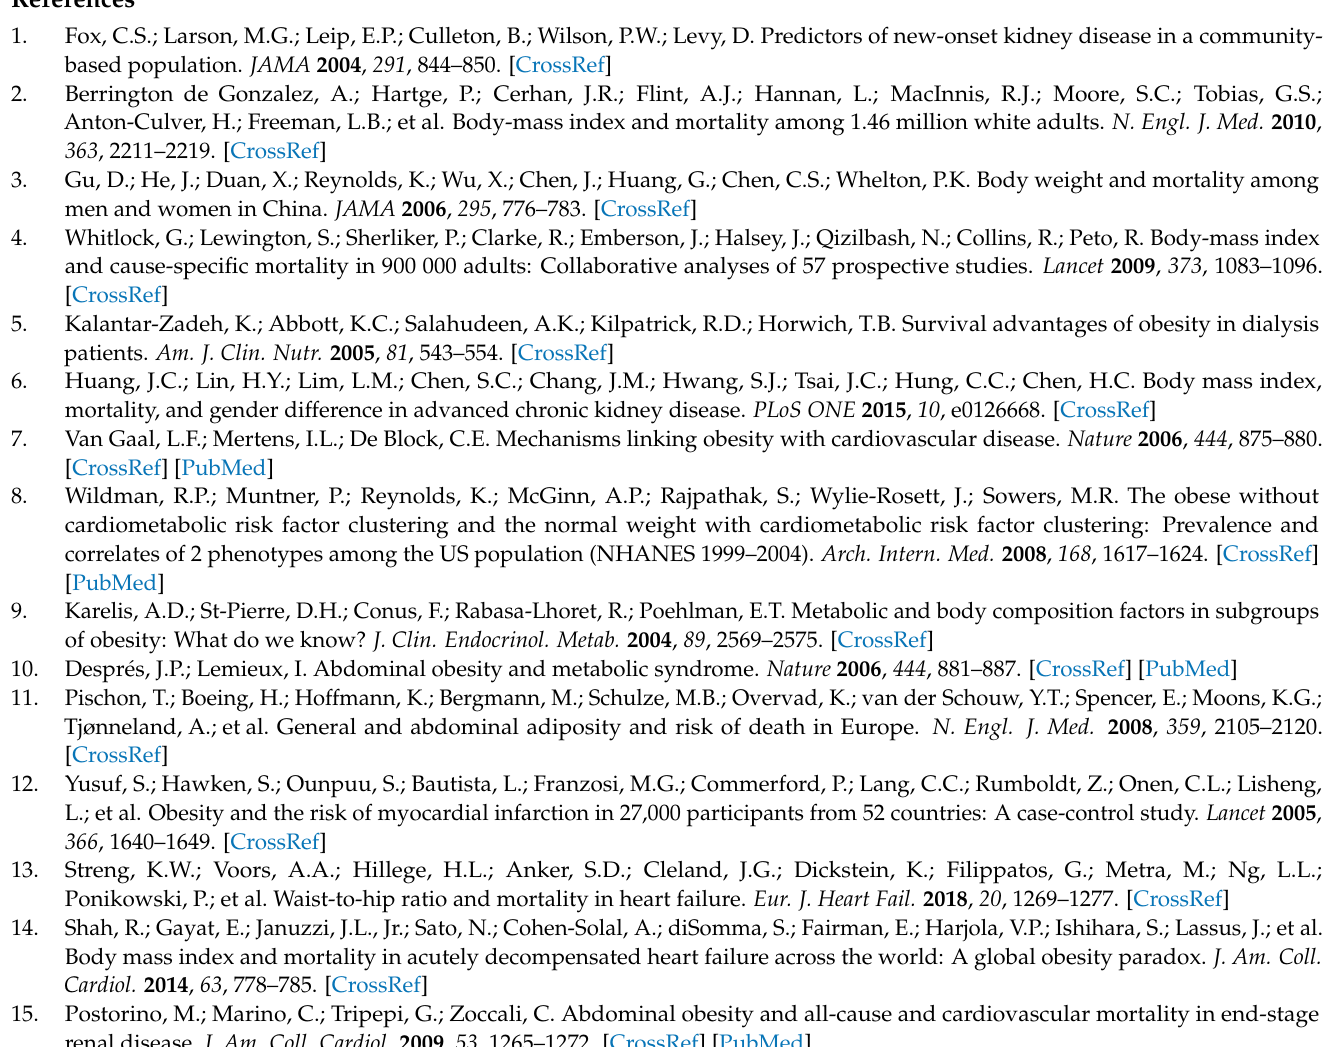
cumference, Supplementary Table S4: Hazard ratios for mortality according to hip-to-height ratio, Supplementary Table S5: Hazard ratios for mortality according to metabolic syndrome components and inflammation, Supplementary Table S6: Hazard ratios for mortality according to malnutrition- inflammation syndrome, Supplementary Table S7: Odds ratios for malnutrition-inflammation ac- cording to body mass index and waist-to-hip